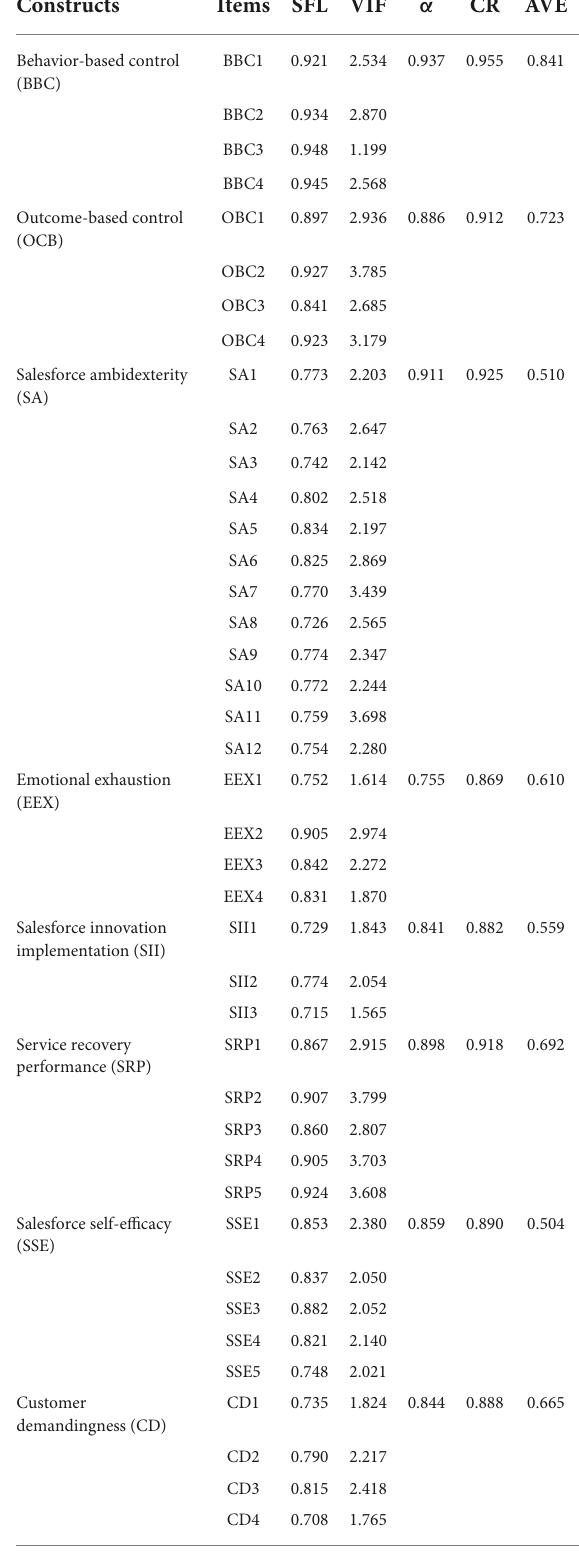
TABLE 2 Discriminant validity. TABLE 3 Factor loadings of measurements